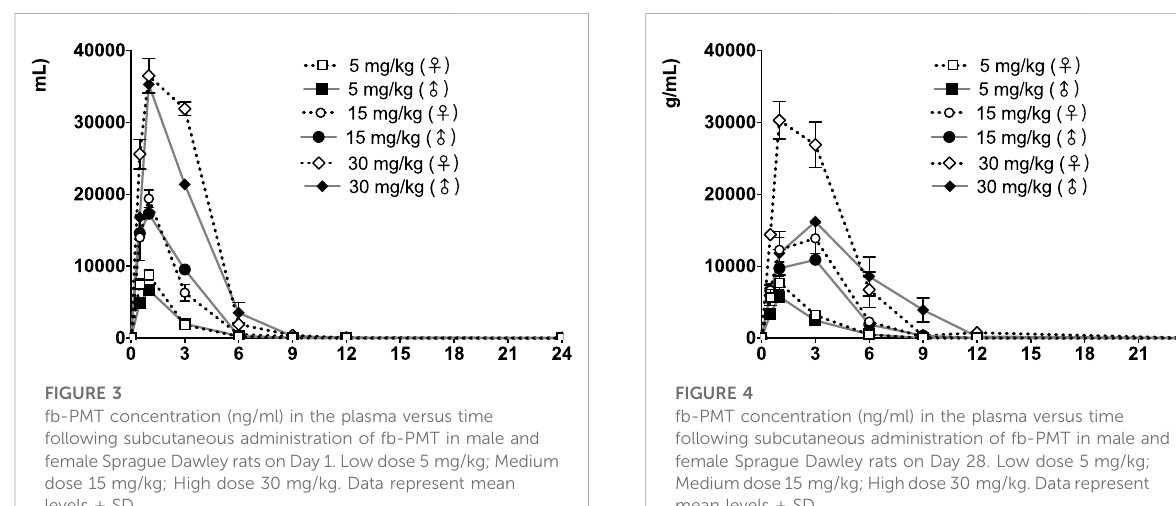
TABLE 2 Pharmacokinetic (Day 1) and toxicokinetic (Day 28) parameters of fb-PMT in male and female Sprague Dawley rats. Day